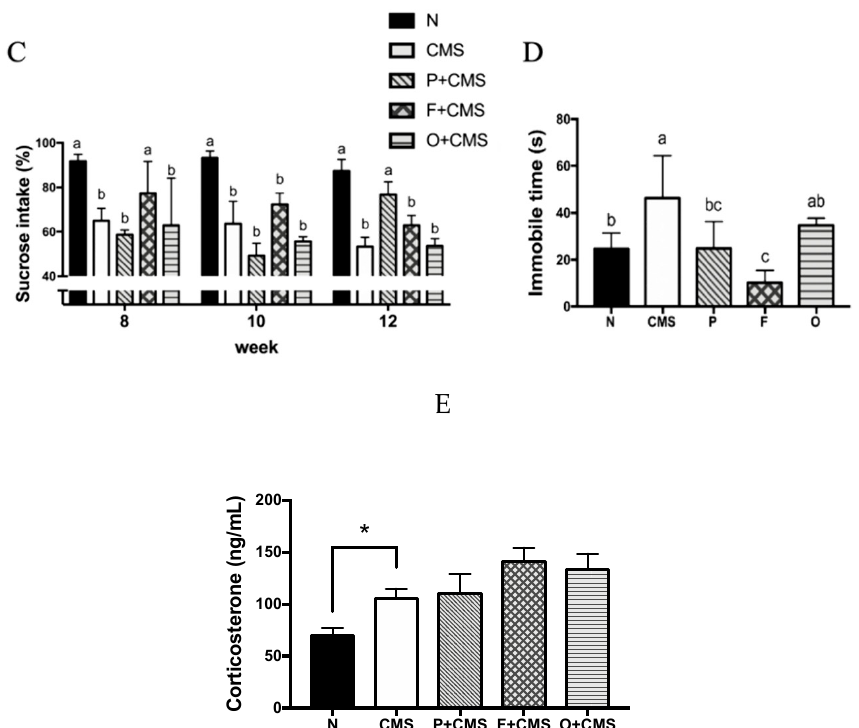
Figure 3. Anxiety-like and depressive-like behavioral tests. ( A ) Total distance traveled and ( B ) central visit duration in the OFT. CMS significantly reduced the total distance traveled. ( C ) Percentage of sucrose water consumed in the SPT. The CMS groups drank significantly less sucrose water. ( D ) Immobile time in the FST and ( E ) corticosterone levels in plasma. CMS significantly elevated the immobile time. Data are expressed as mean ± SD (n = 6 per group). * Significantly different using Student’s t test ( p < 0.05). Values with different superscript letters are significantly different at p < 0.05.